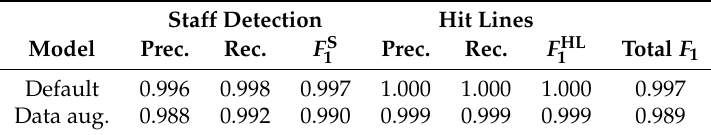
Table 3. Staff detection and the number of recognised lines in a detected staff with and without data augmentation. The last column combines the two individual F 1 measures by